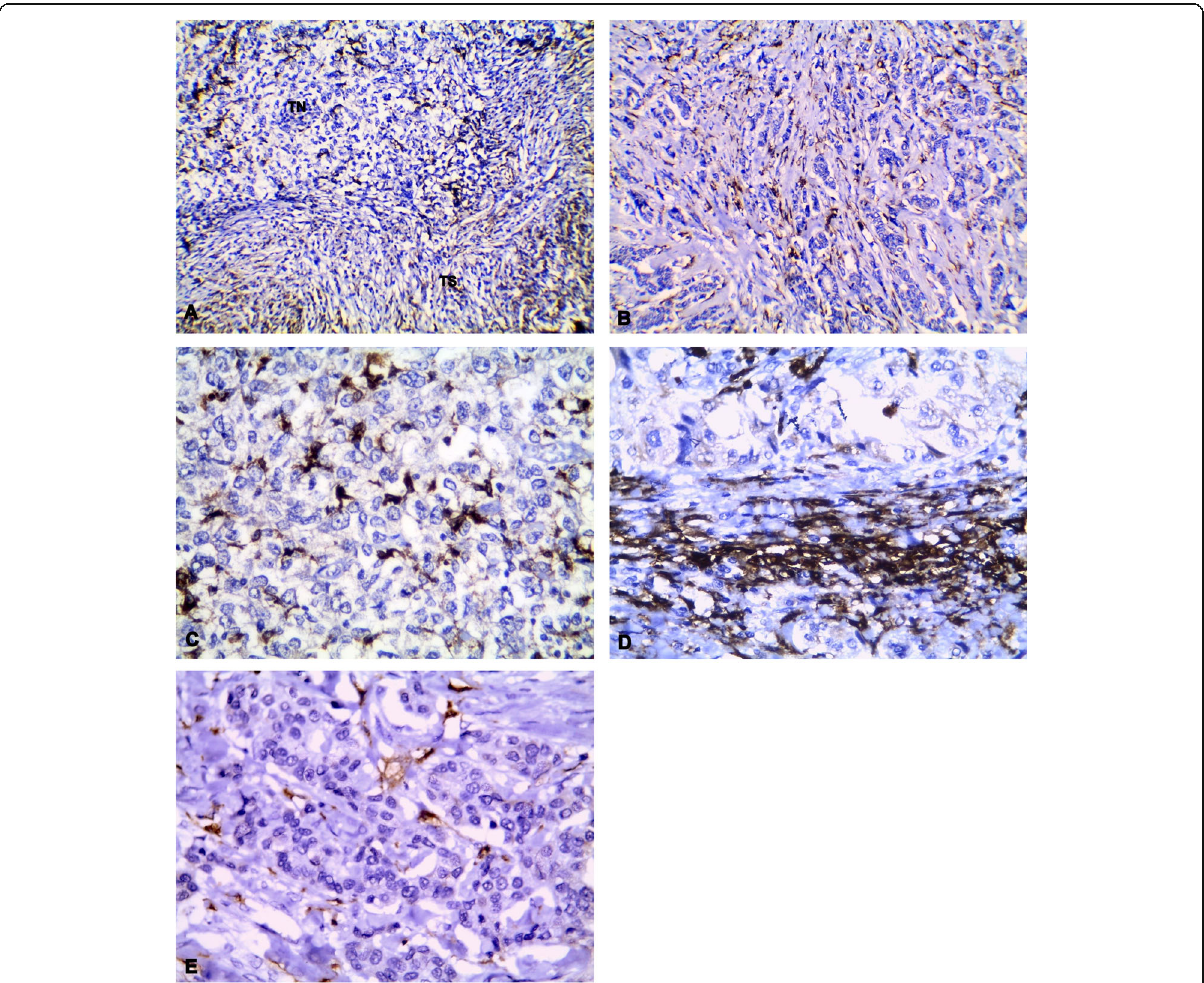
Fig. 1 CD68-positive tumor-associated macrophages (TAMs). a CD68-positive TAMs mainly in tumor stroma (TS) with few within tumor nest (TN) in GIII case (× 200). b CD68-positive TAMs within tumor stroma in GII case (× 200). c High density of CD68-positive TAMs within tumor nest in